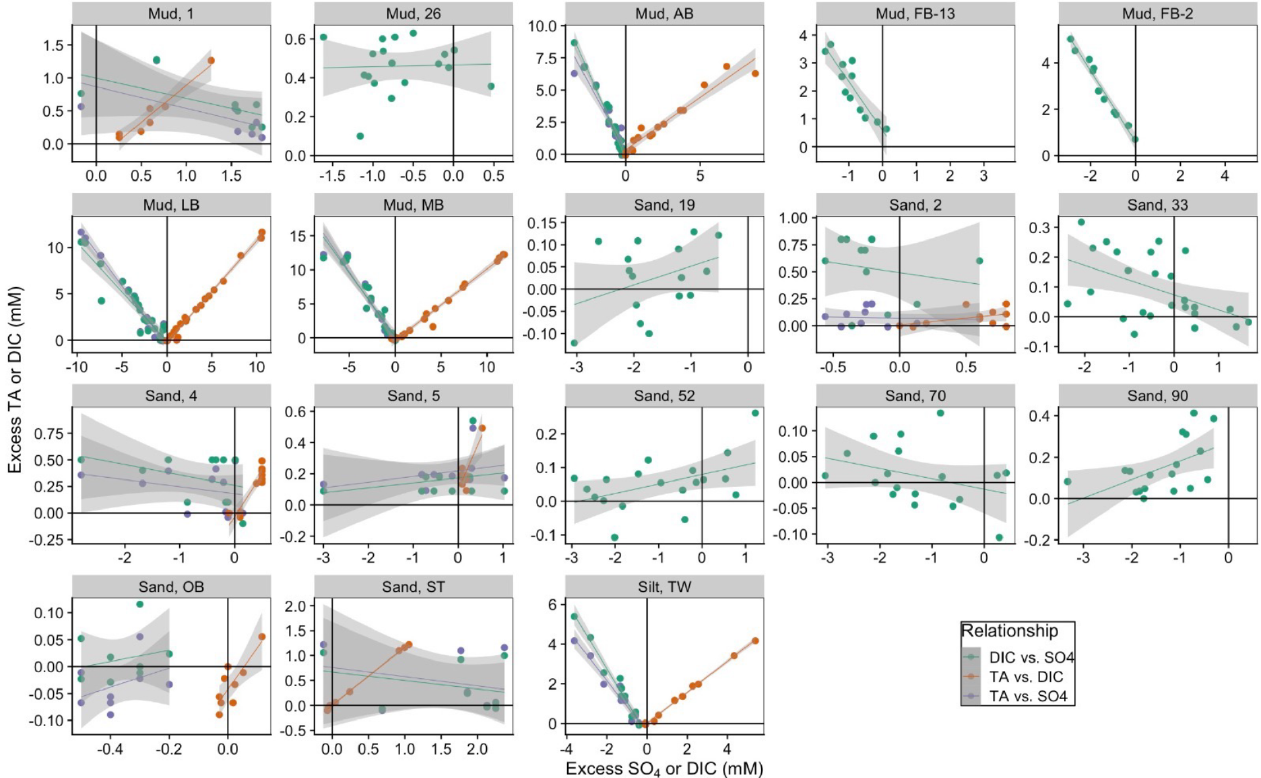
Figure 6. Relationships between excess DIC and excess SO 2 − SO 2 − (purple points). Positive values indicate a larger concentration in porewater relative to surface 4